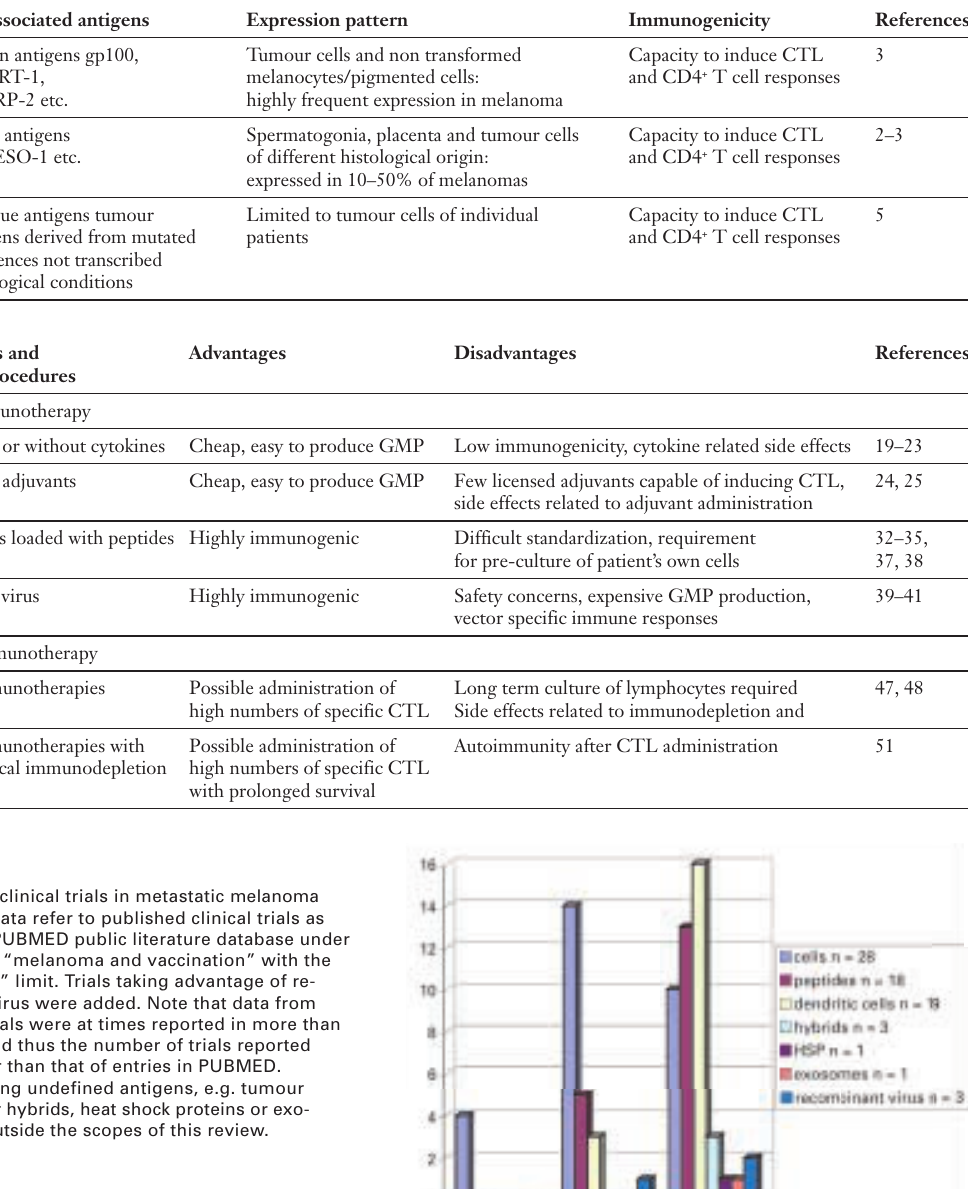
An overview of melanoma associated antigens.